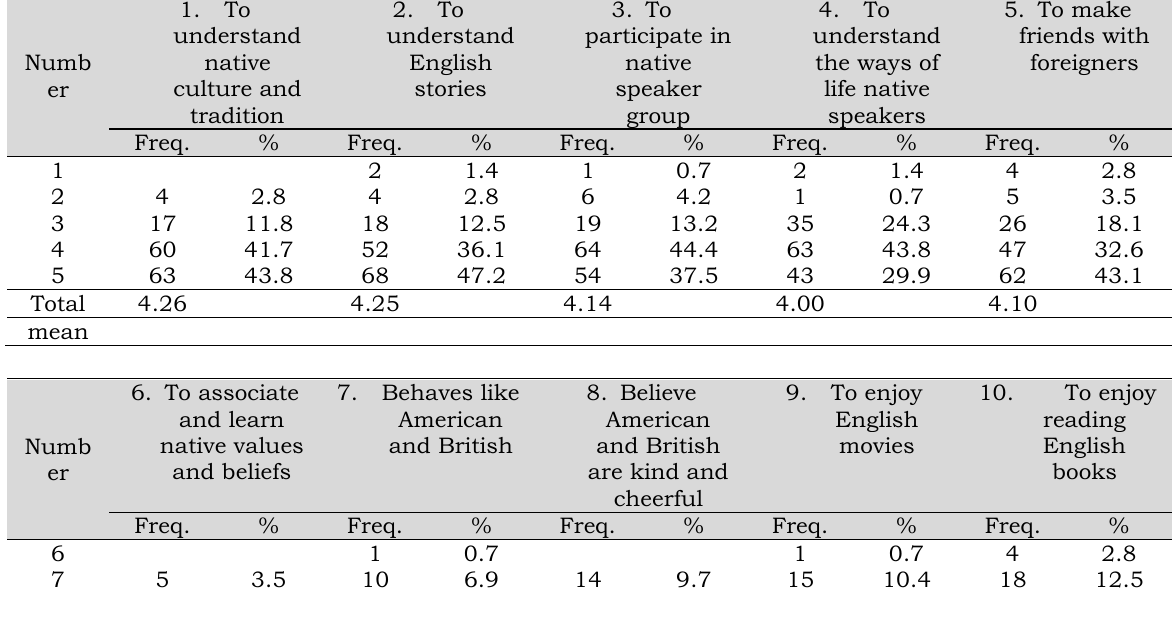
Table 2. Integrative orientation (frequency distribution and mean